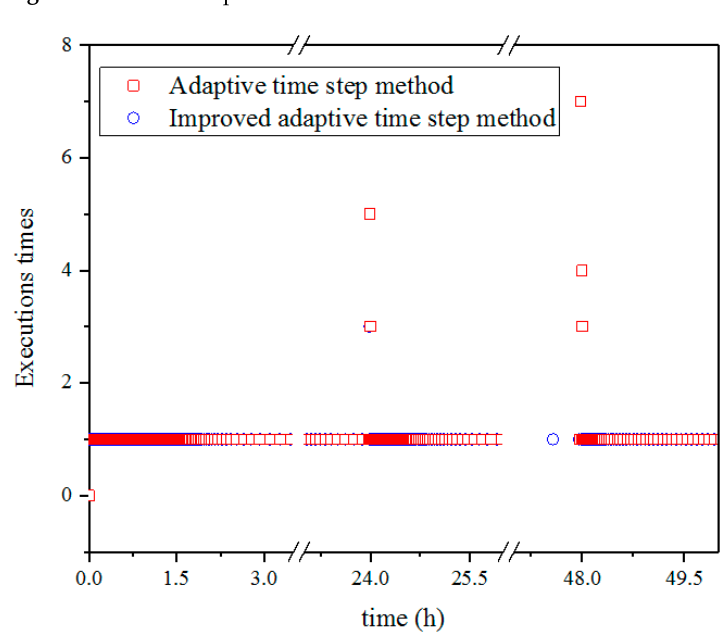
Figure 4. The time step versus time.